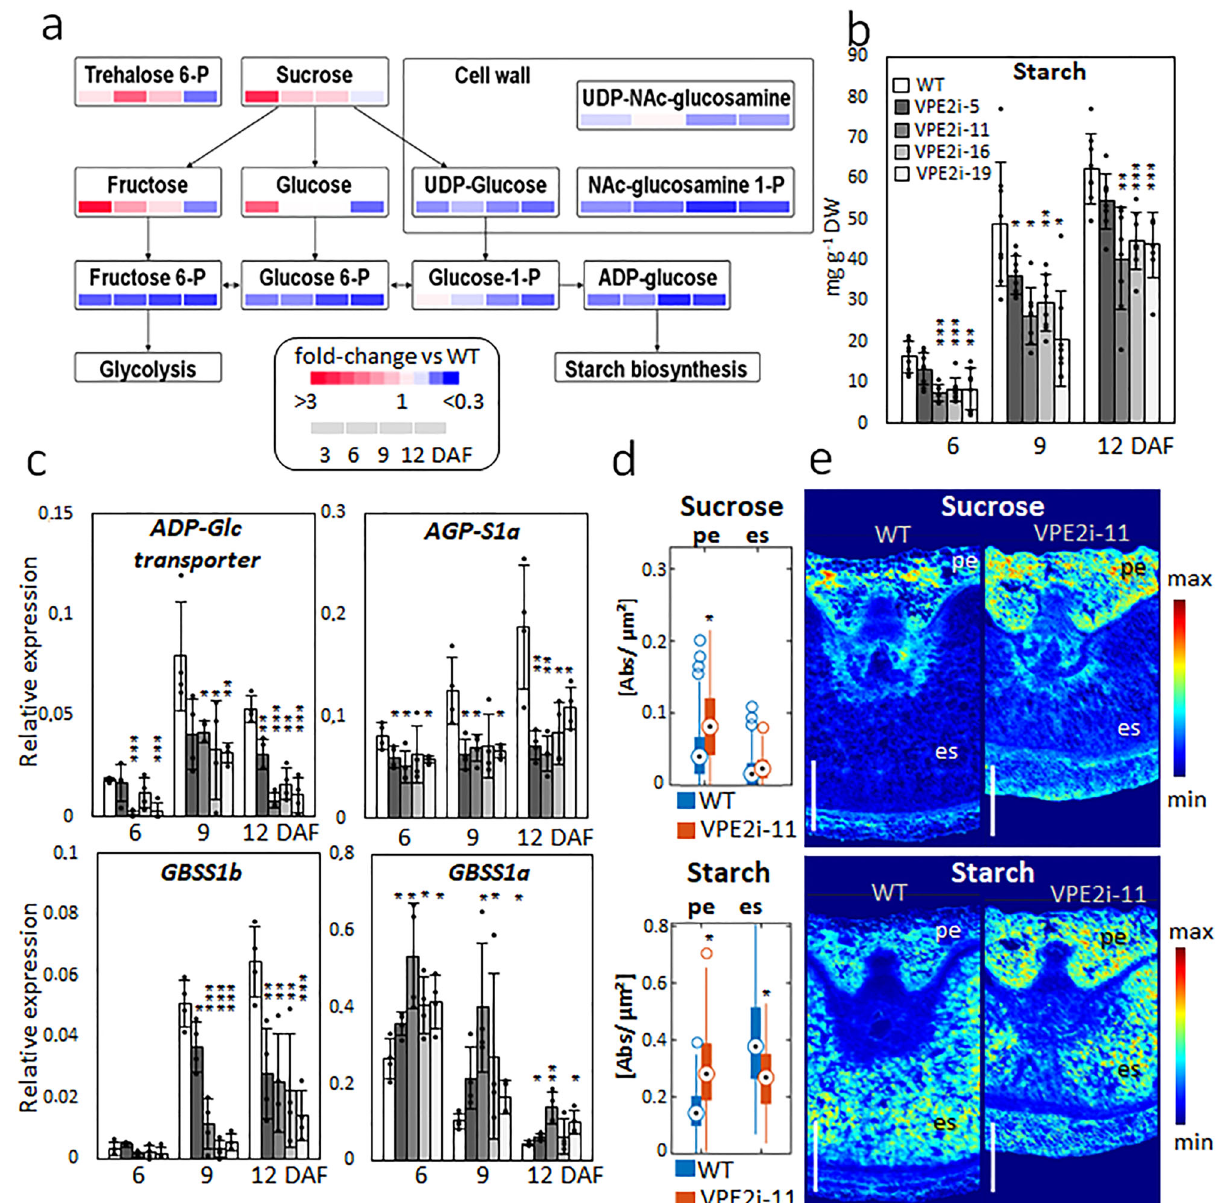
Fig. 6 The suppression of the VPE2 subfamily compromises the accumulation of starch in the endosperm. a A metabolite heat map illustrating the abundance of various sugars in the developing grain. b Temporal pro fi le of starch accumulation in WT and RNAi-VPE2 transgenic lines. c The abundance of transcripts generated from genes encoding an ADP-glucose transporter ( AGP-Glc transporter ), small subunit S1a of AGPase ( AGP-S1a ), and granule-bound starch synthases 1a ( GBSS1a ) and 1b ( GBSS1b ) in the grain of WT and transgenic lines. d Comparative Fourier-transform infrared (FTIR) analysis of sucrose and starch in pericarp ( PE ) and endosperm ( ES ) of WT and transgenic grains measured at 9 DAF. Data are given in relative units (dot point, median; box, interquartile range [IQR]; lines, 1.5 × IQR; stars indicate statistical signi fi cance at P < 0.05 by the Mann – Whitney U test). e Representative FTIR-based images of sucrose (upper panels) and starch (lower panels) in WT and transgenic grains. The concentrations are color-coded. Bars = 500 µ m. Data shown as the mean ± SD ( n = 8 in a and b , = 4 in c , = 5 in d ). *, **, ***: means differ at, respectively, P < 0.05, < 0.01, and < 0.001. Abbreviations: DAF days after fl owering, es endosperm, pe pericarp, WT wild